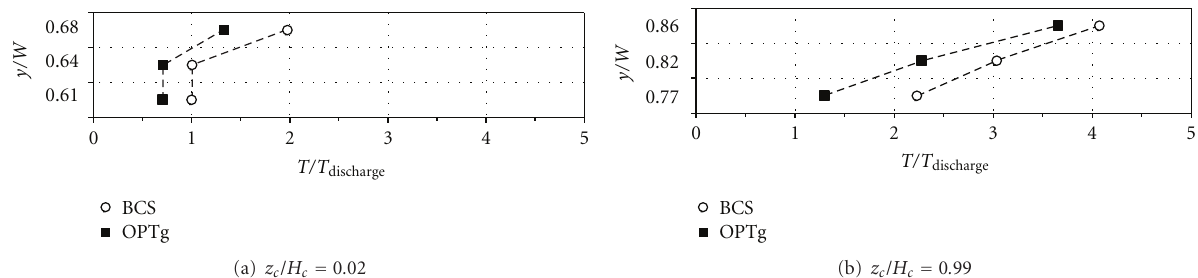
Figure 14: Comparative profiles of nondimensional air temperature, T/T discharge ( y/W , z c / H c ), in the air curtain—OPTg case study.